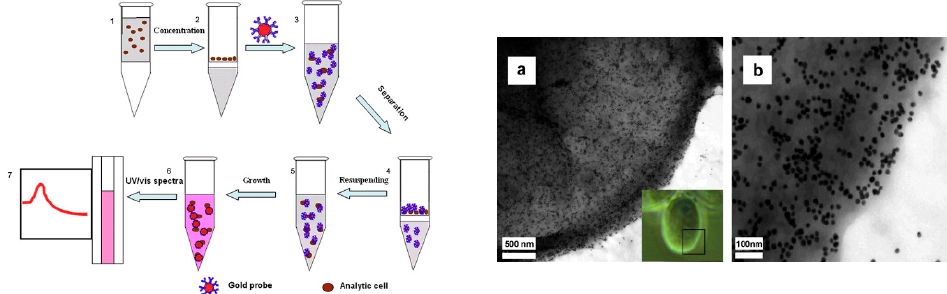
Figure 8. AuNPs-based immunosensor for Giardia lamblia cysts detection. ( Left ) The sample is concentrated through a centrifuge filter, and then incubated with Ab-AuNPs immunoprobes. The binding is quantified as a color change of the AuNPs detected by UV-spectroscopy. The ( Right ) image shows TEM images of immunoprobes on the surface of Giardia lamblia cysts at a scale of ( a ) 500 nm and ( b ) 100 nm. Giardia lamblia cysts morphology is shown in the inset (adapted with permission from [16]).